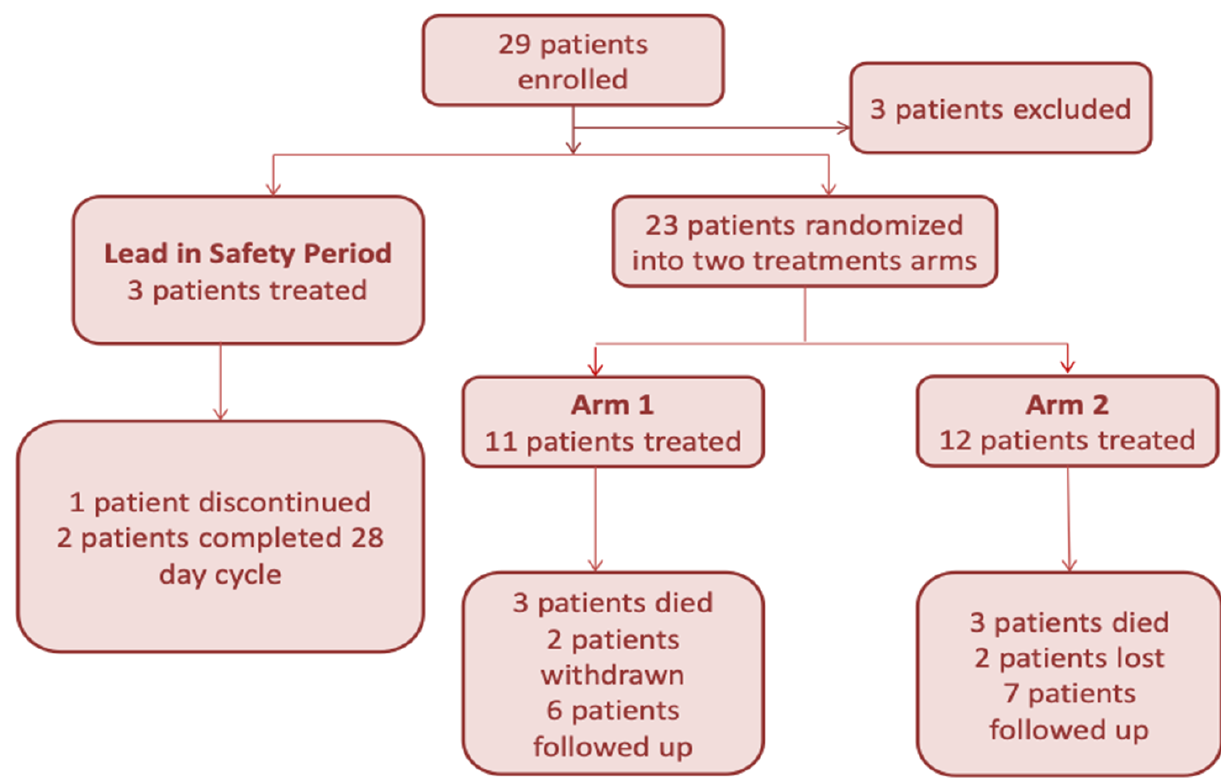
Figure 2. Phase Ib/IIa study design and assessment of patients receiving Atu027 and gemcitabine therapy.